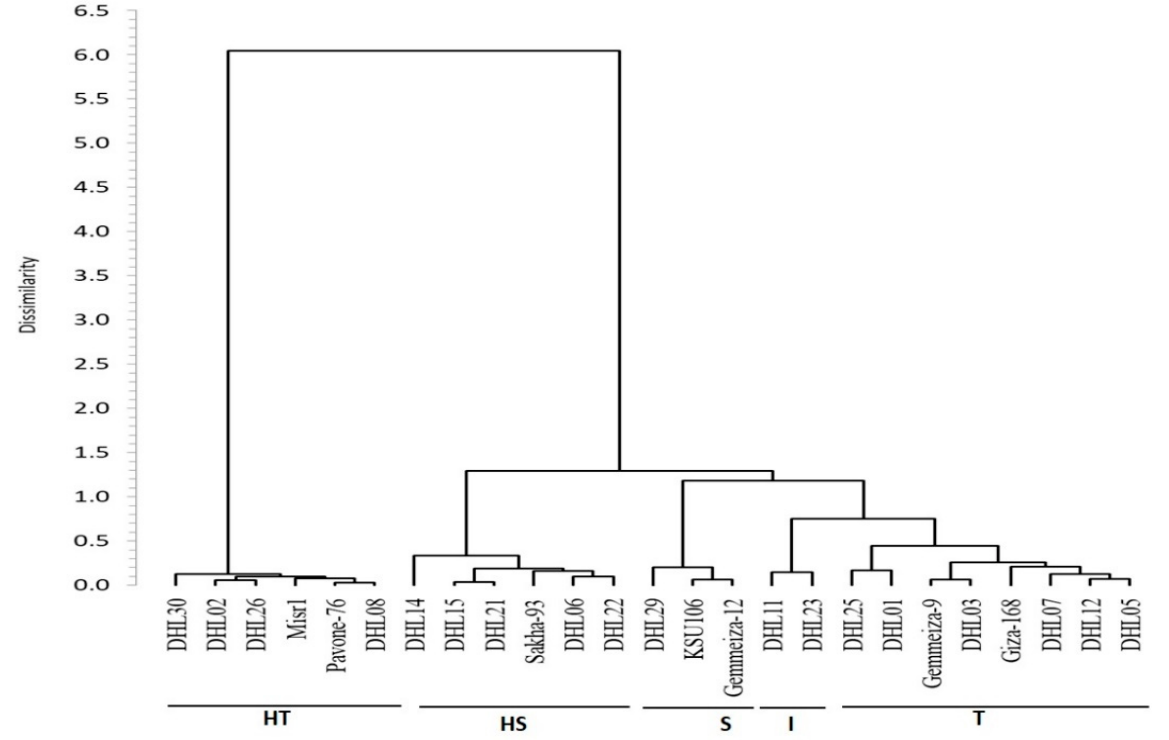
Figure 2. Dendrogram showing clustering of 25 wheat genotypes based on the Euclidean distance of relative water content, canopy temperature, leaf area index and green leaf area.